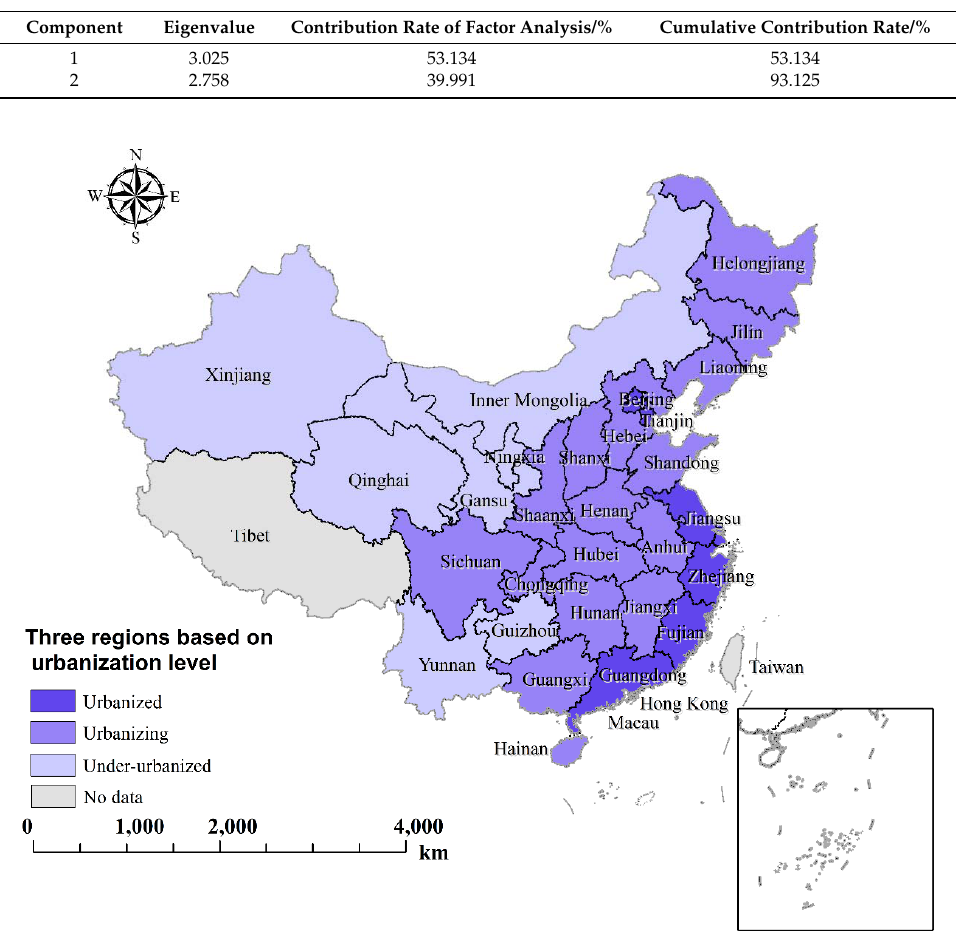
Table 3. The eigenvalues and cumulative contribution rates of the degrees of urbanization.